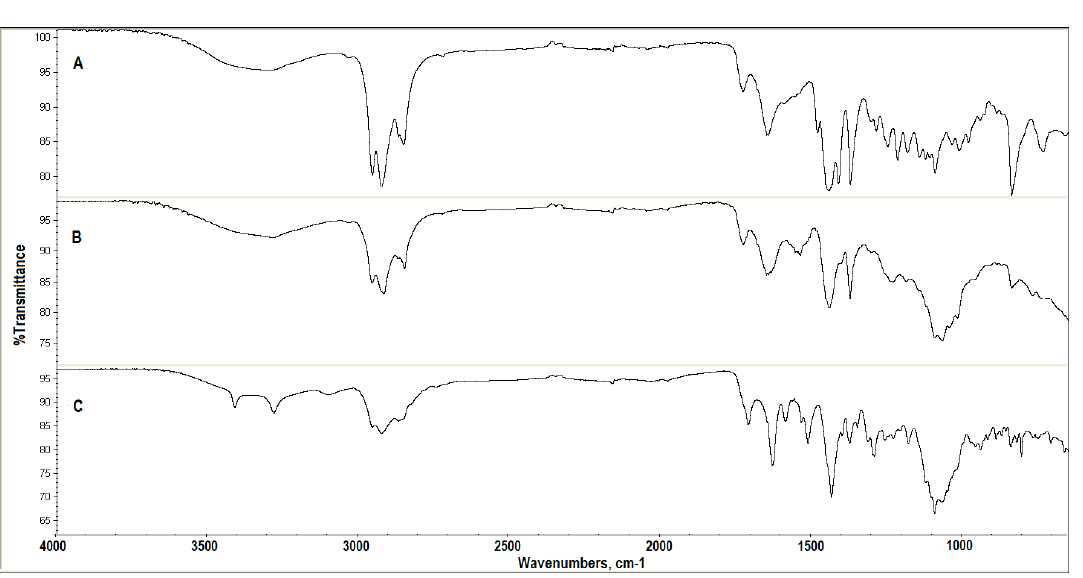
Figure 3 . FTIR spectra of catheter surface recorded during a two-stage modification using the SPA-M3 method: the untreated hydrogel catheter ( A ), the bromine-activated catheter ( B ), and the SPA-treated catheter ( C ).